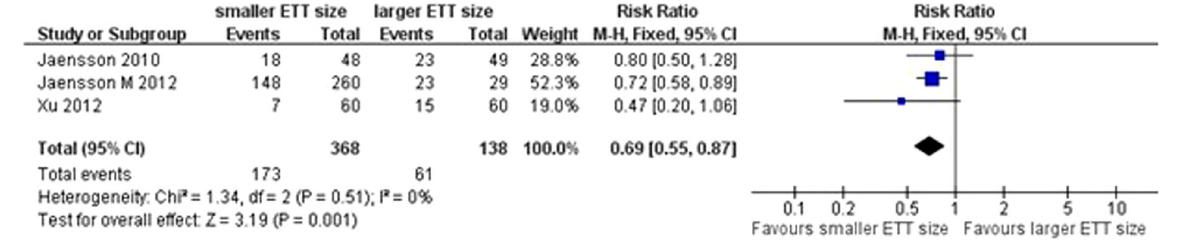
Figure 6. Forest plot of comparison of PH in PACU.